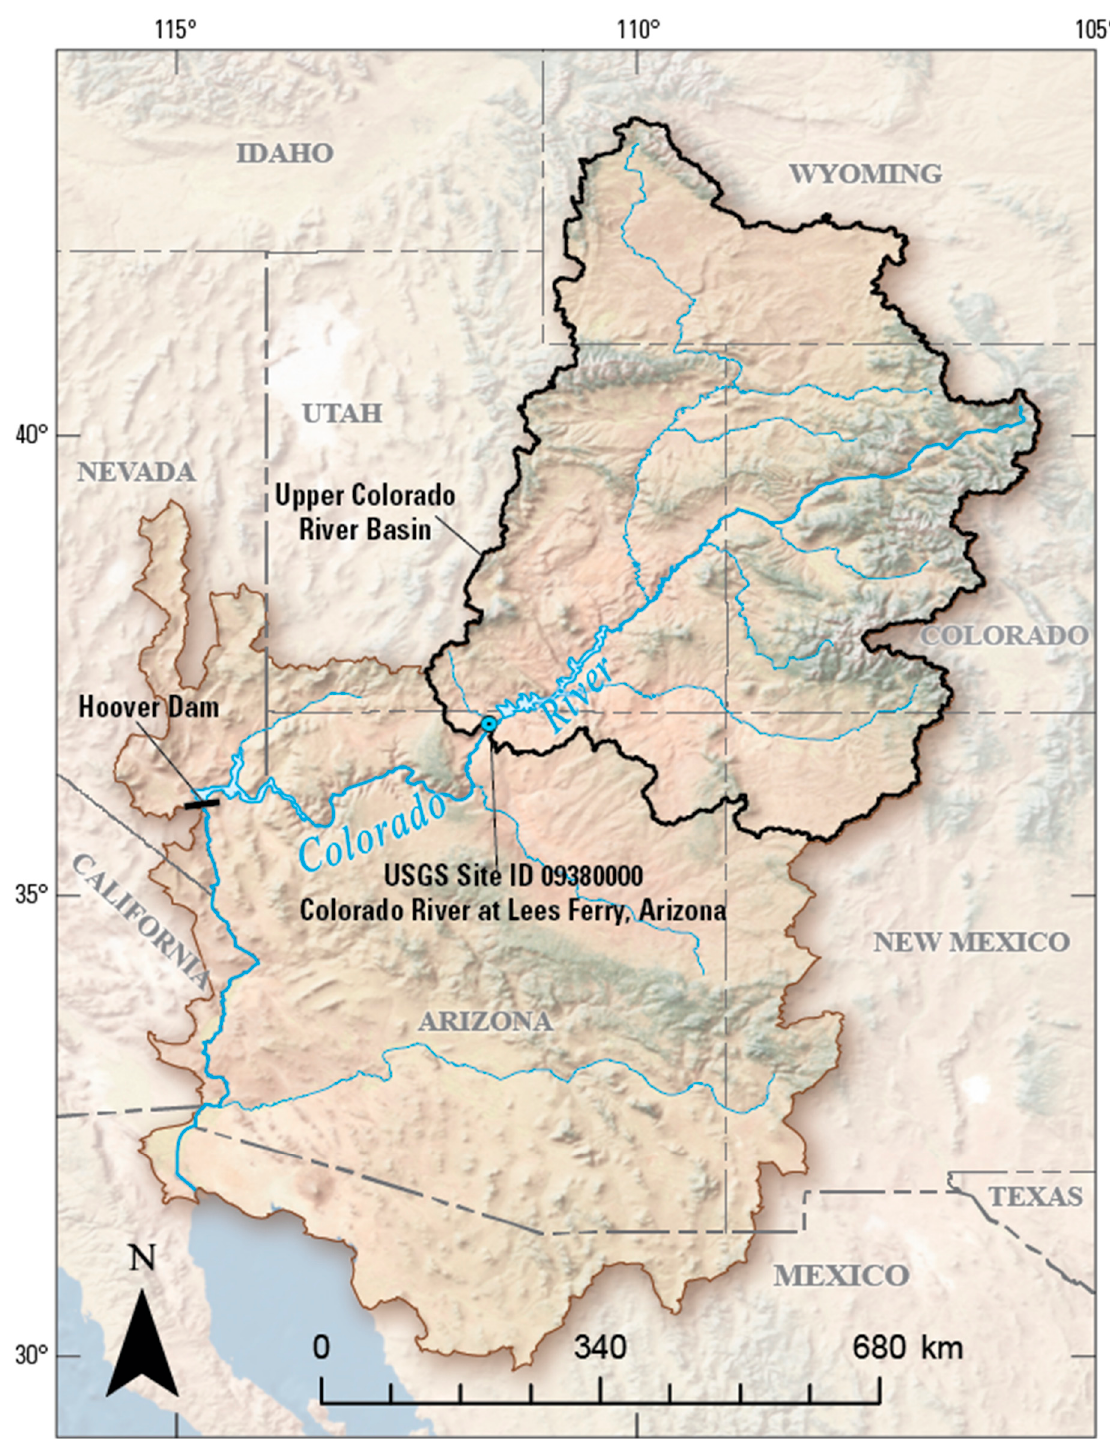
Figure 1. The Colorado River Basin in the southwestern United States and northern Mexico.